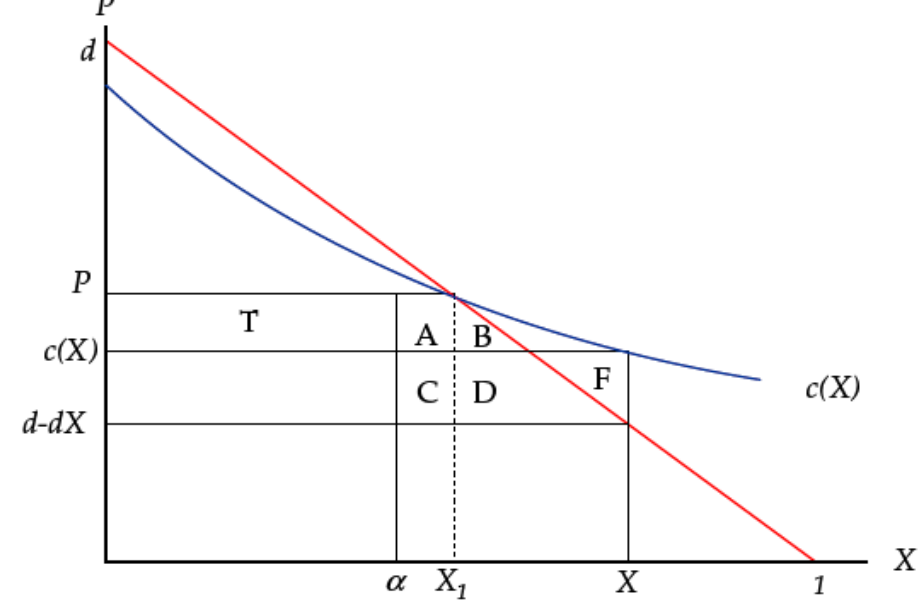
Figure 1.Welfare improvements of self-financing tax subsidy